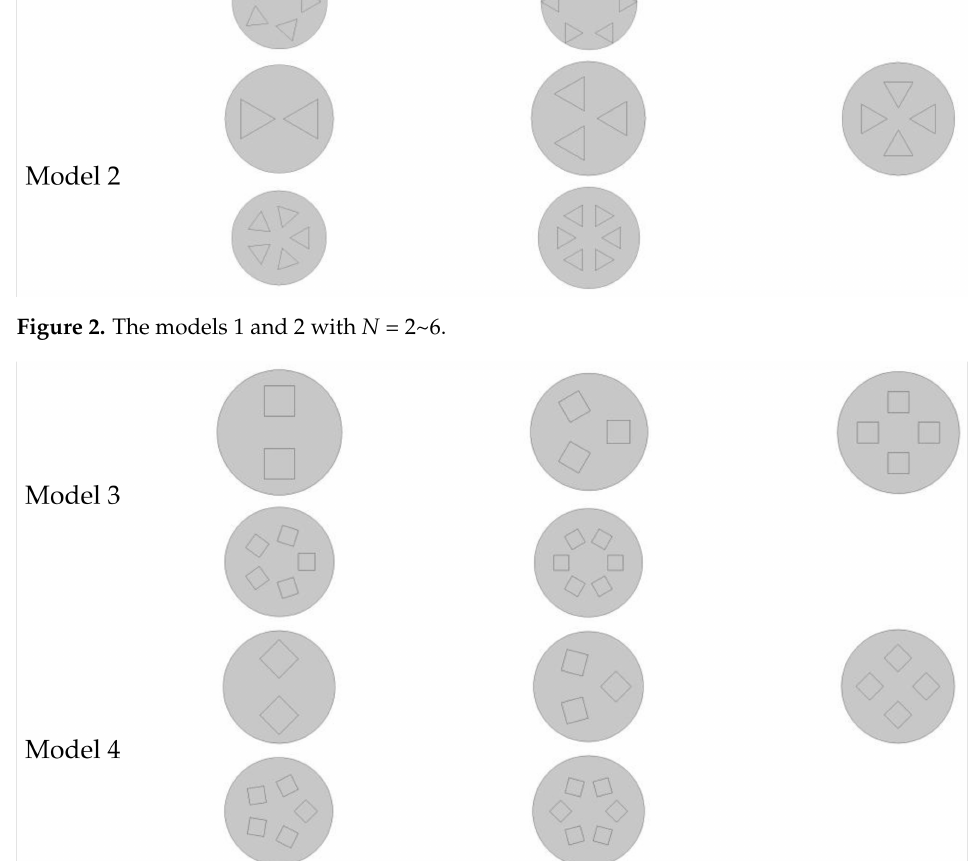
Figure 3. Models 3 and 4 with N =